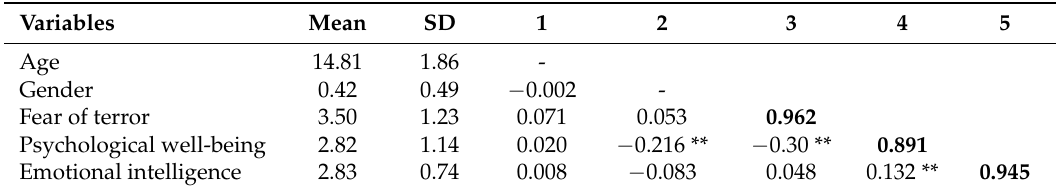
Table 2. Descriptive analysis including means, standard deviations, and correlation between the study